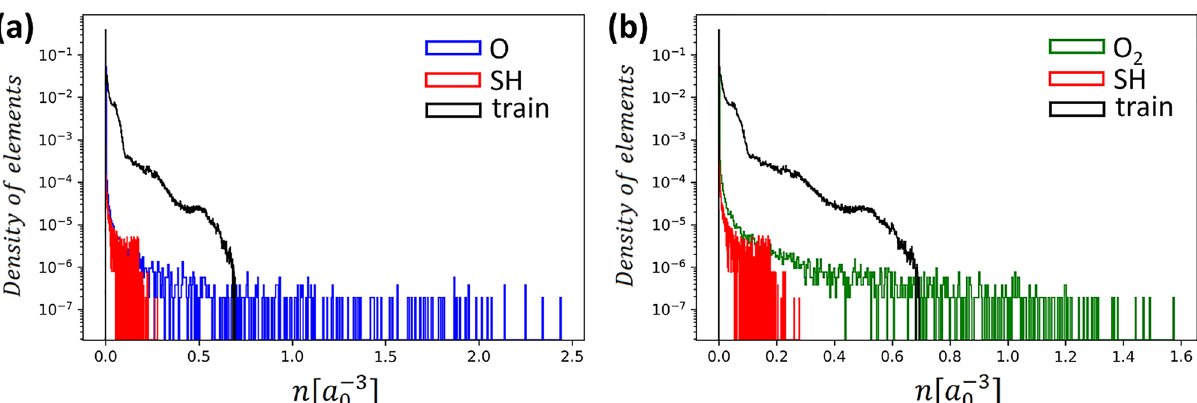
Figure 5. Comparison of distribution for non self-consistent electron density of atomic oxygen ( a ), molecular oxygen ( b ), hydrogen sulfide and self-consistent electron density from training ( a 0 denotes the Bohr radius). One can see that atomic and molecular oxygen have a significant fraction of samples out of the train distribution. The step of the self-consistent cycle with maximum electron density was chosen for all substances. This example emphasizes the importance of including a wide range of electron density and derivatives in the training dataset because extreme values could occur during the self-consistent